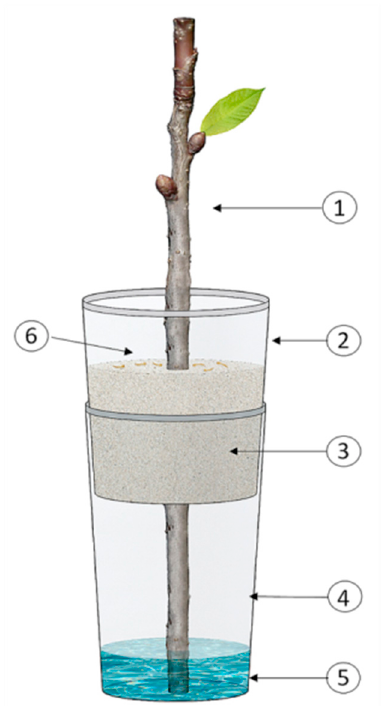
Figure 1. Schematic of the experimental microcosm applied to evaluate the susceptibility of Capnodis tenebrionis neonates to Mb7-GFP under laboratory conditions modified from Azoulay [28]: (1) Apricot twig; (2) 250 mL cup; (3) Sandy soil mixed with Mb7-GFP or fungus-free (control); (4) 500 mL cup; (5) 2.5 cm layer of water; (6) Site of C. tenebrionis neonate release.